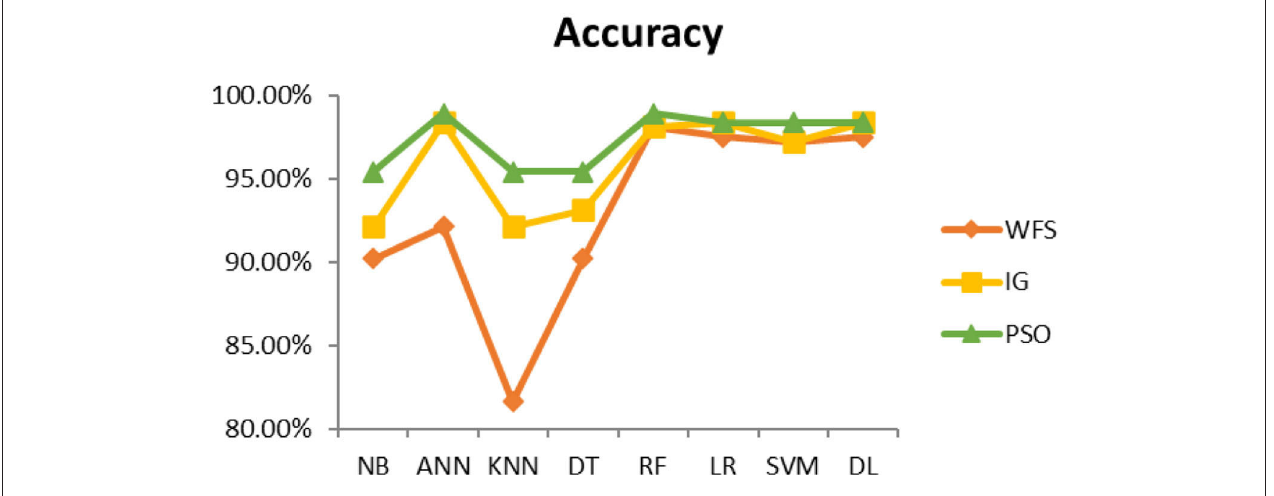
FIGURE 11 | Kidney disease diagnosis accuracy.